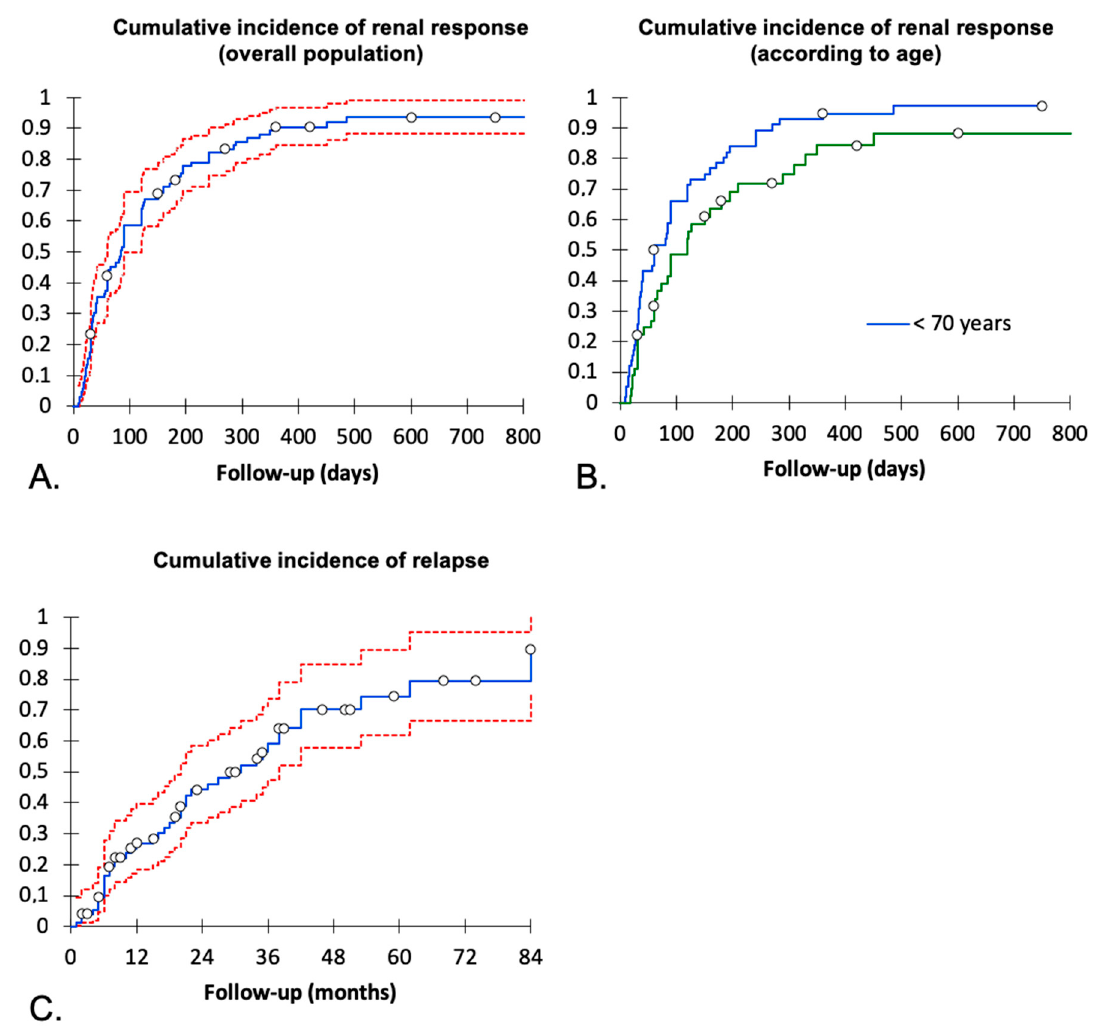
Figure 2. Outcomes of the idiopathic nephrotic syndrome in patients older than 60 years of age. Cumulative incidence of renal response (complete or partial) following the frontline therapy (( A ) overall population. ( B ) Cumulative incidence according to the age at presentation, green line: age at the onset <70 years, blue line: age at the onset ≥ 70 years). Time of follow-up consisted of the time from presentation to the best renal response after the frontline therapy. In patients receiving a second- line therapy due to no or partial renal response, follow-up was stopped at the time of its introduction. In patients not responding and that did not receive a second-line therapy, last follow-up was used to estimate the cumulative incidence. ( C ) Cumulative incidence of renal relapse in patients that reached partial or complete response. Red lines represent the 95% confidence interval.